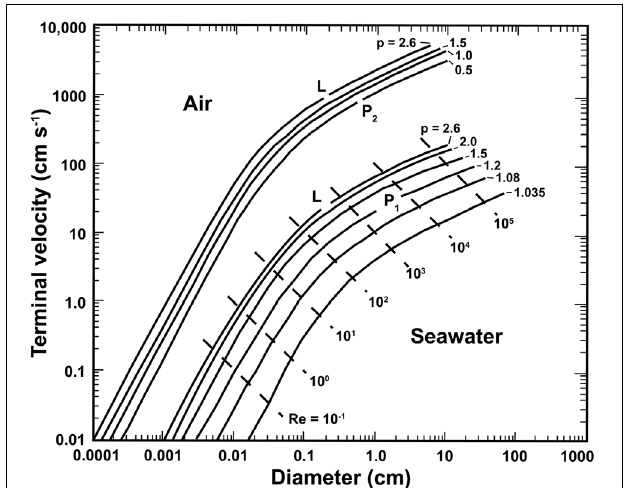
FIGURE 9 | Terminal settling velocities of pyroclasts of different grain sizes and densities in air and in water according to the Stokes’ Settling Law, showing orders of magnitude slower velocities in water than in air. (After Cashman and Fiske, 1991, Figure 2 ; permission American Association for Advancement of